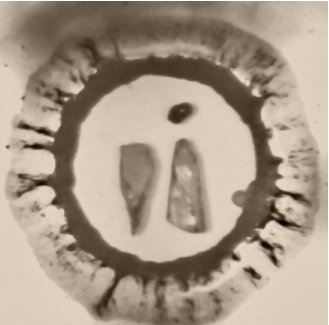
Figure 9. Loading of 4HCB in He at 6.7GPa that show the two single crystals of 4HCB, the ruby, and the